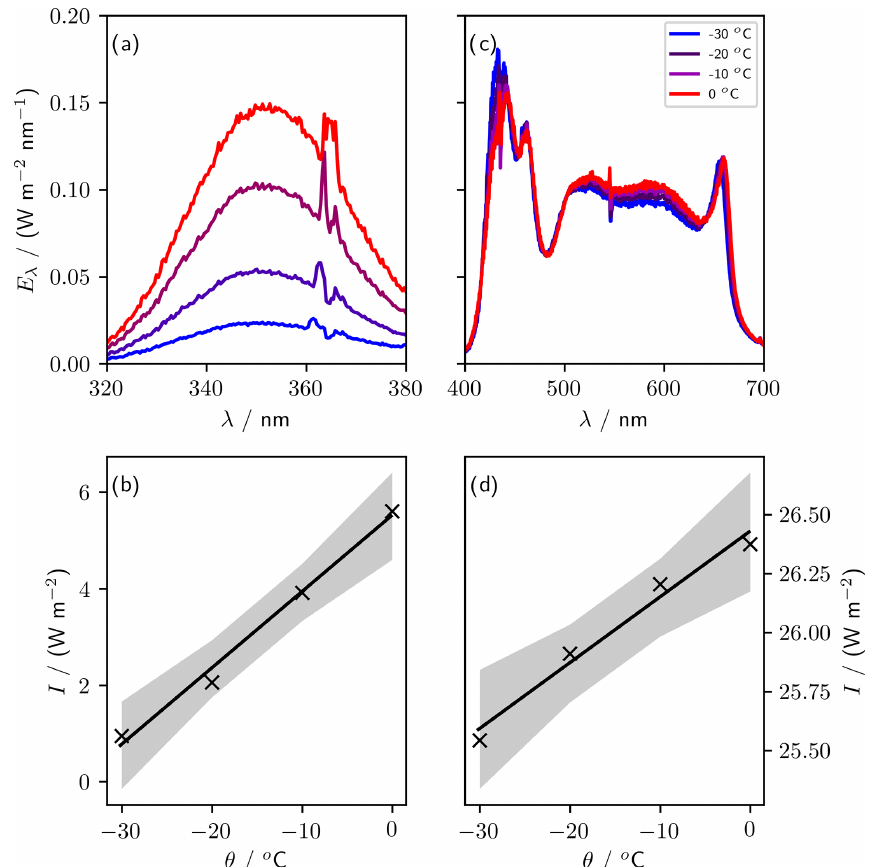
Figure 9. Sensitivity of lights to variations in temperature. Panels (a) (UV) and (c) (PAR) show spectra taken at four temperatures between 0 and − 30 ◦ C. Panels (b) (UV, 320 to 380nm) and (d) (PAR, 400 to 700nm) show the irradiance, I (integrated spectral irradiance over the respective wavelength ranges), at each temperature, θ . The gradient of the regression of I against θ is (0 . 028 ± 0 . 003)Wm − 2 ◦ C − 1 for PAR and (0 . 16 ± 0 . 01)Wm − 2 o C − 1 for